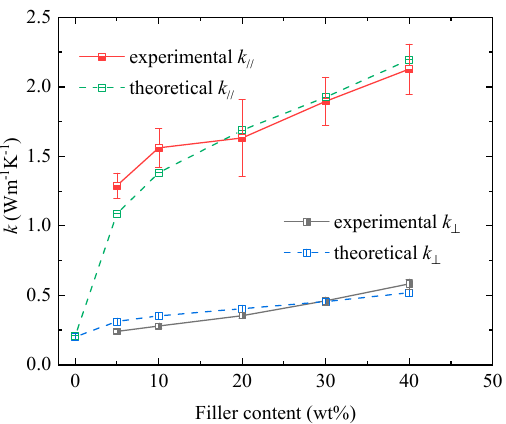
Figure 6. In-plane and through-plane thermal conductivities of HF-Ti 3 C 2 T x / epoxy composites, in which the theoretical ones are simultaneously calculated by Chen model [36,37].